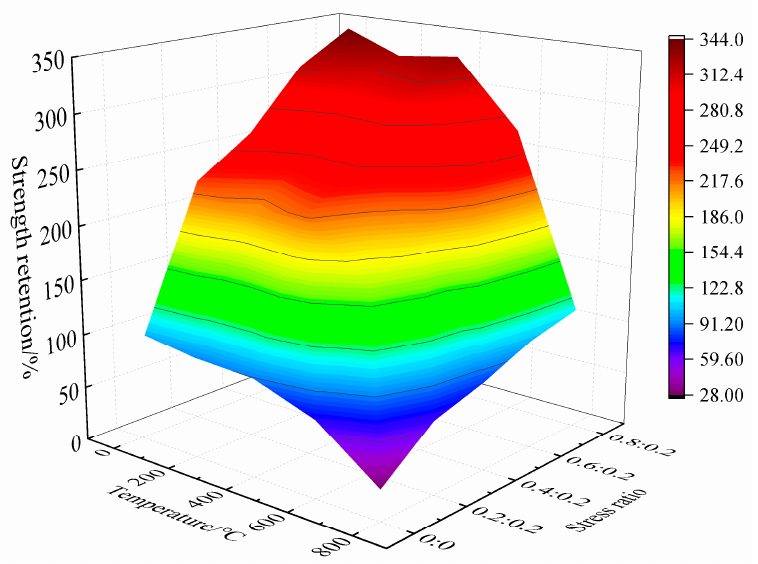
Figure 7. Strength retention rate of concrete under the coupling action of high temperature and biaxial unequal lateral pressure.